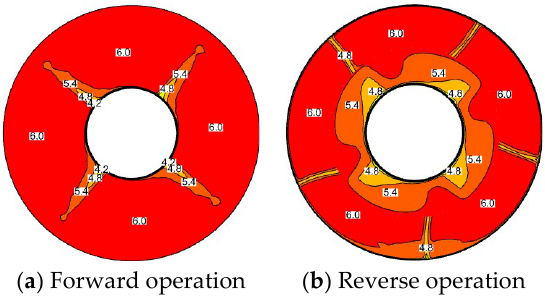
( b ) Reverse operation Figure 16. 0.9 Q d impeller inlet axial flow velocity distribution cloud diagram.